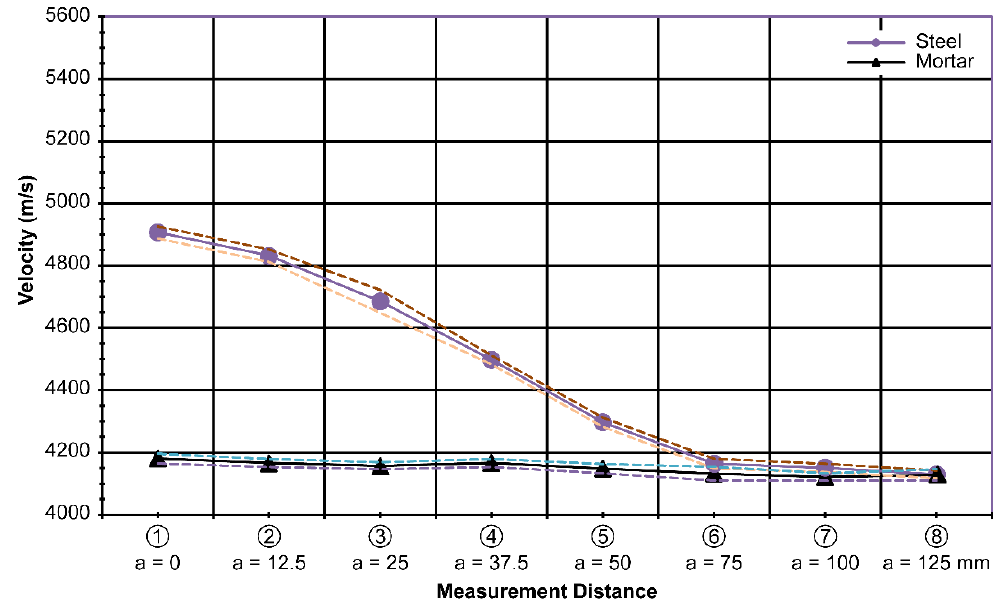
Figure 11. Integrated measurements according to varying steel heights(h)at t = 20 mm and d = 75 mm.